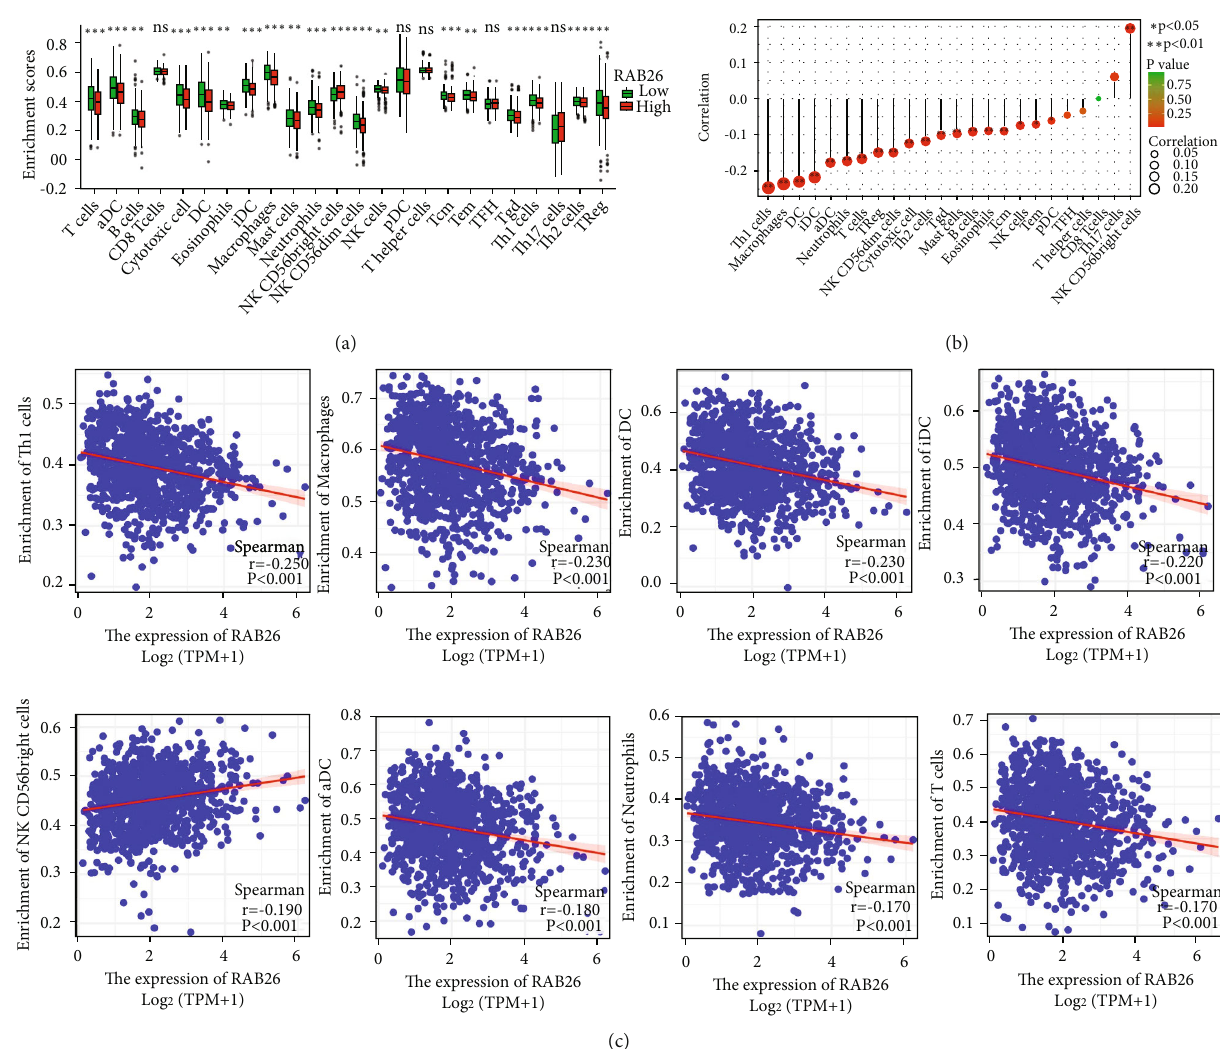
Figure 8: Correlation between RAB26 expression and immune cells in TCGA-LUAD cohort (n =447). (a) Box plot demonstrating the in fi ltration levels of immune cells in the high- RAB26 -expression versus the low- RAB26 -expression group. (b) Lollipop chart demonstrating the correlation between RAB26 and 24 immune cell types. (c) Correlation scatter plot of 8 cells with the largest correlation coe ffi cient with RAB26 . The asterisks represent the statistical p -value ( ∗ p < 0 : 05 ; ∗∗ p < 0 : 01 ; ∗∗∗ p < 0 : 001